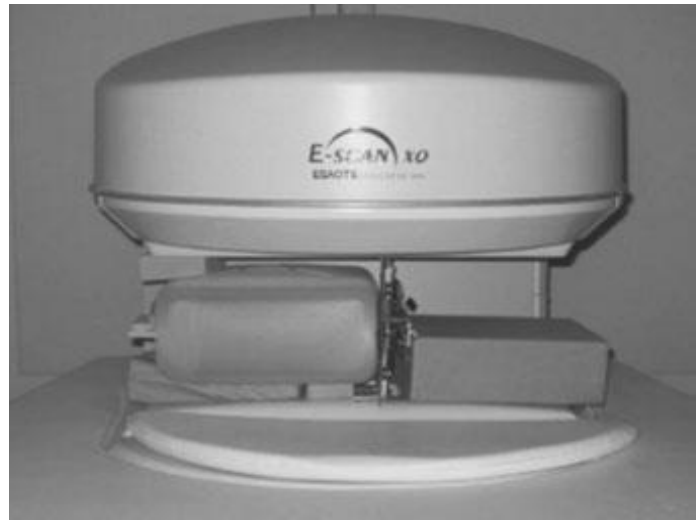
Figure 8. The MR experimental set-up. Reprinted from [44].